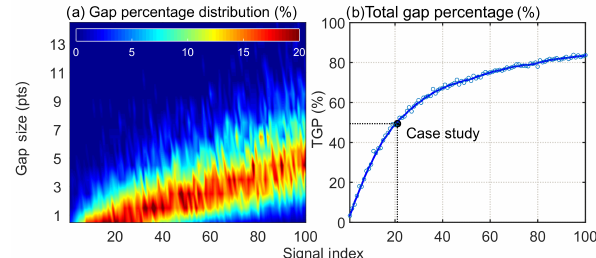
Figure 8. MSG test applied to the synthetic data: (a) distribution of gap percentage (color coded) as a function of signal index and gap size; (b) TGP as a function of signal index. Note that for the MSG test, the TGP is not a linear function of signal